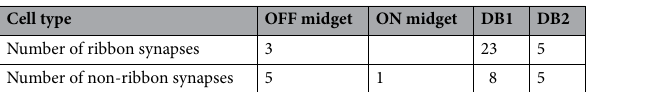
Table 2. Bipolar cells presynaptic to displaced ipRGC 11345 from the nasal volume. Note that input from type DB1 predominated. Each type of presynaptic bipolar cell made at least one synapse without a ribbon. The presynaptic bipolar cells could not be identified at 12 synapses. Together, these bipolar cells made 62 synapses onto ipRGC11345. Of these 66% (41/62) had ribbons and 34% (21/62) did not.